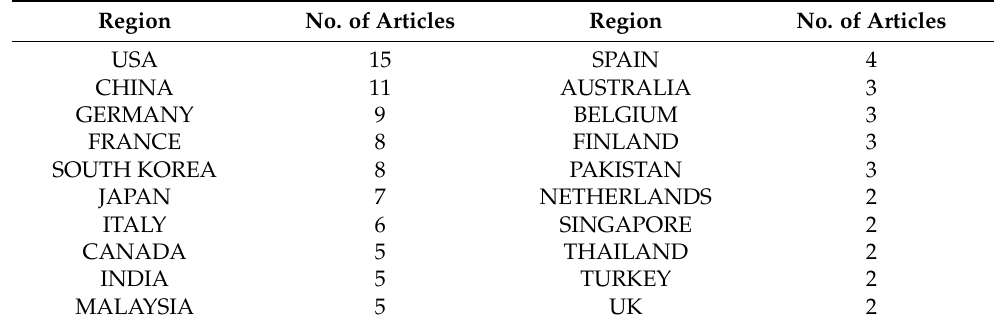
Table 3. Top 20—Most productive countries (based on first author’s